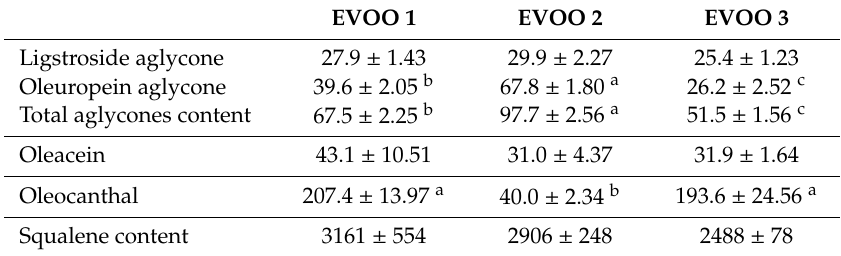
Table 2. Oleacein, oleocanthal, oleuropein and ligstroside aglycones and squalene concentration (mg kg − 1 ) in EVOO extracts, as obtained from 1 H NMR spectral analyses. Data are shown as mean ± SD. One-way ANOVA was performed (Bonferroni test correction p < 0.05). For the same compound, di ff erent letters indicate di ff erences among the